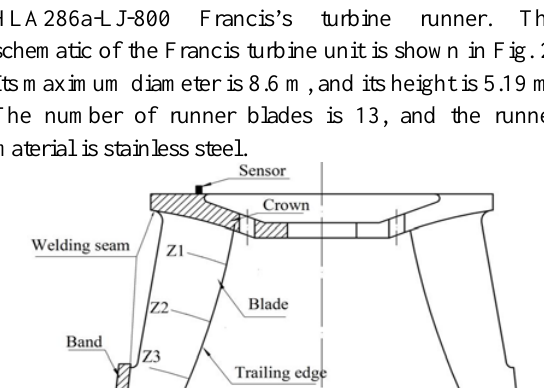
via Physical Acoustics Corporation (PAC) SAMOS system. The PAC R6-a AE sensors (35-100 kHz) and model 2/4/6 pre-amplifiers (10 kHz- 2MHz) were